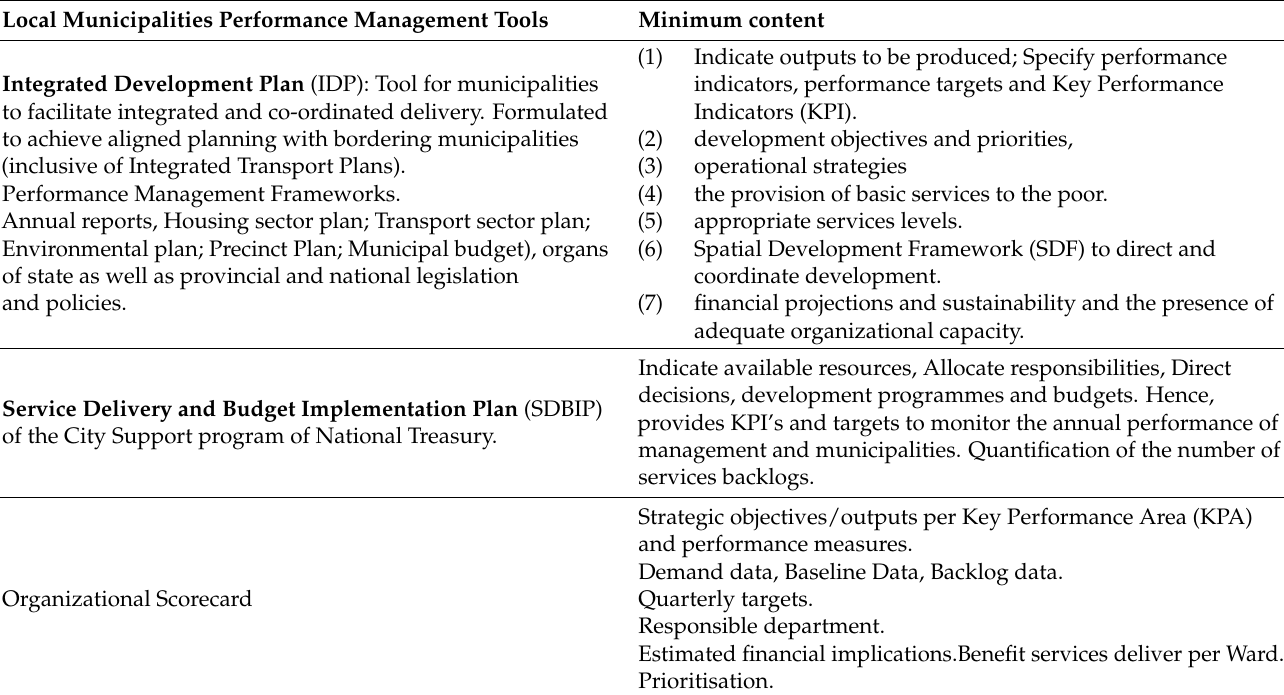
Table 4. Available Performance Management Tools (Source: Own construction from COGTA Guide- lines,